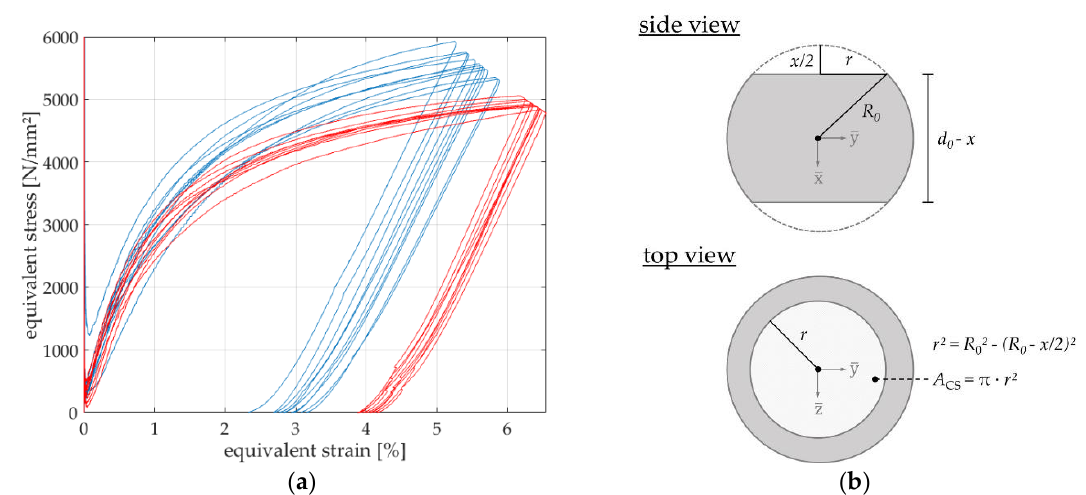
Figure 6. ( a ) Results of micro compression tests (equivalent stress-strain relation) of the heat treatment conditions Q2-180 °C (blue) and Q2-300 °C (red); ( b ) determination of the area of the circle segment 𝐴 𝐶𝑆 for the calculation of 𝜎 according to Equation (3) of a theoretically purely plastically deformed microsphere after compression.